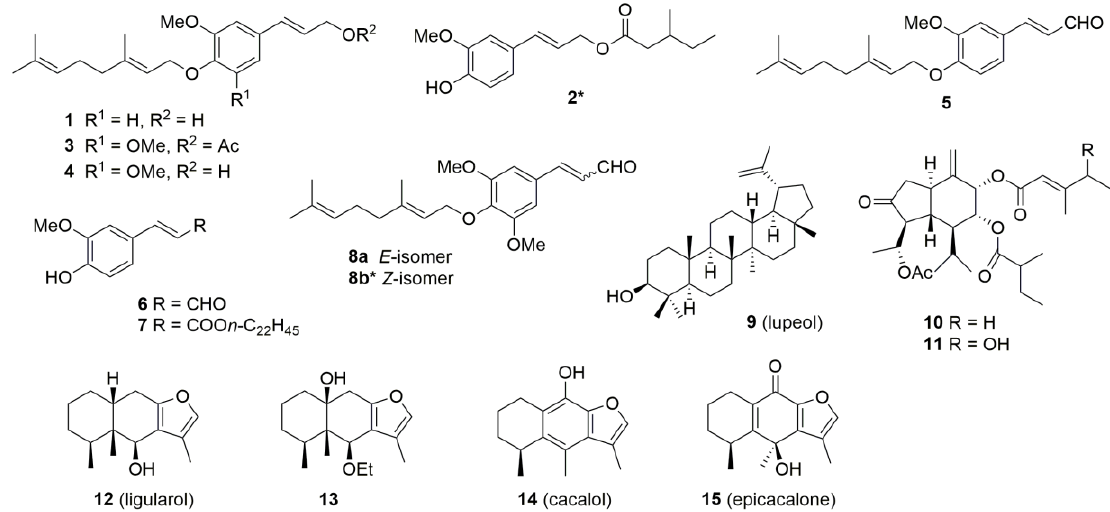
Figure 2. Isolated compounds from L. duciformis / L. kongkalingensis / L. nelumbifolia (samples 1–8) and L. limprichtii (sample 9). Asterisks indicate new compounds.